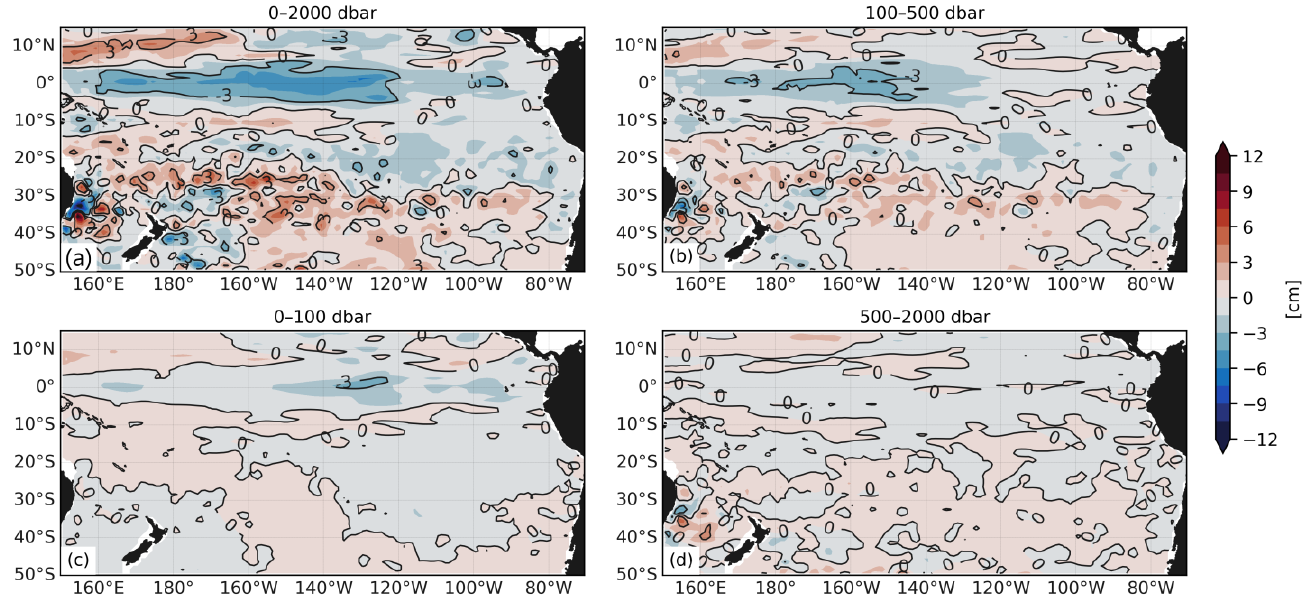
Figure 7. Differences in the Roemmich-Gilson Argo-based thermosteric sea level (TSL) for 2020 minus 2018 over ( a ) 0 – 2000 dbar, ( b ) 100 – 500 dbar, ( c ) 0 – 100 dbar and ( d ) 500 – 2000 dbar. Contour lines (see inline numbers for TSL intervals) are also shown.